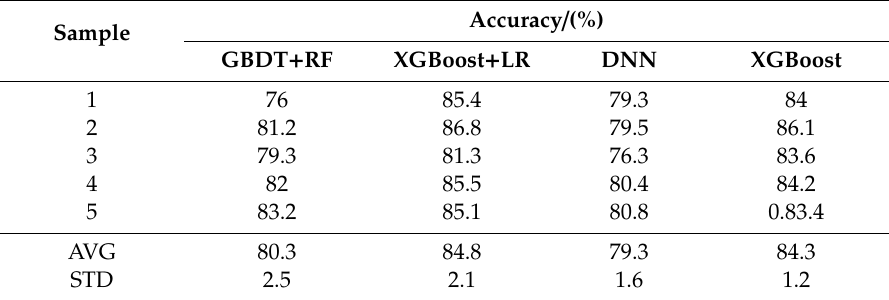
Table 4. Comparison results of 5-fold cross-validation using four models.